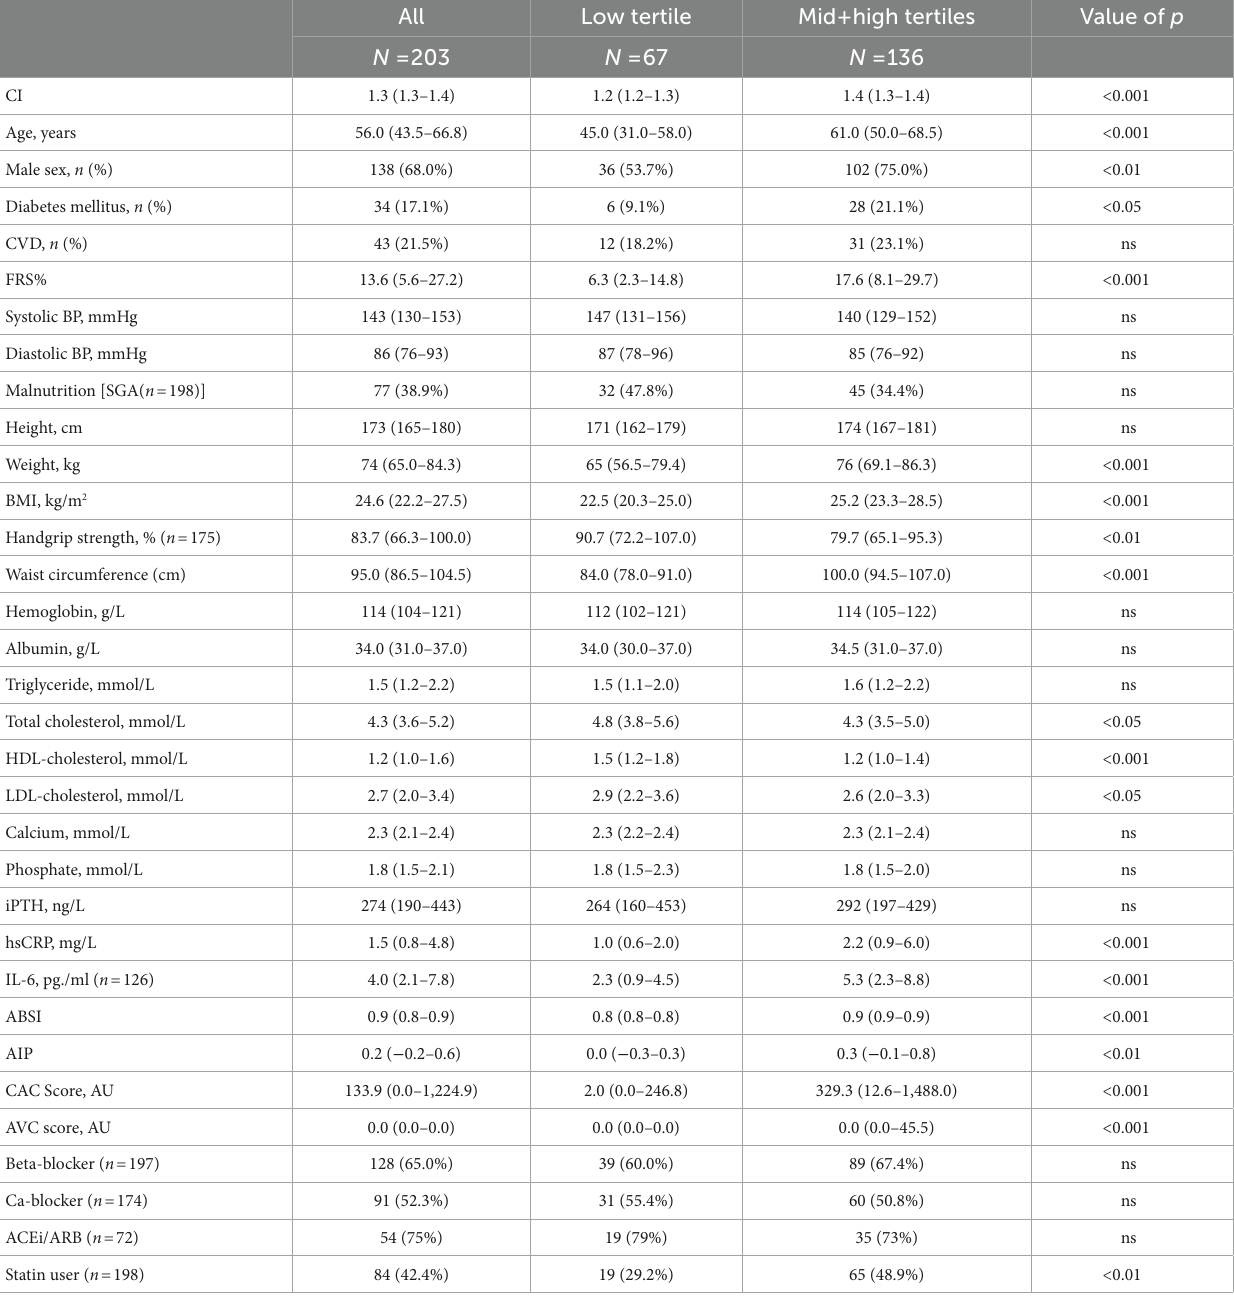
TABLE 1 Baseline clinical and biochemical characteristics of 203 chronic kidney disease stage 5 (CKD5) patients according to tertiles of conicity index (CI).